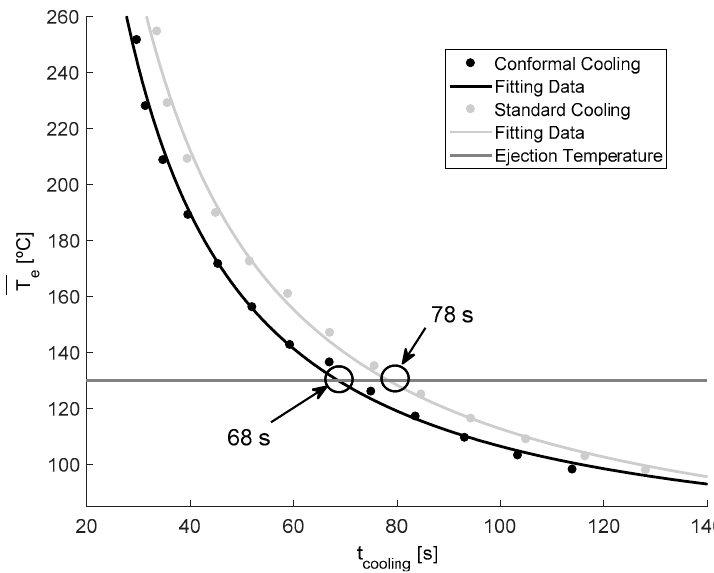
Figure 20. Cooling time [s] versus mean integral temperature [°C].